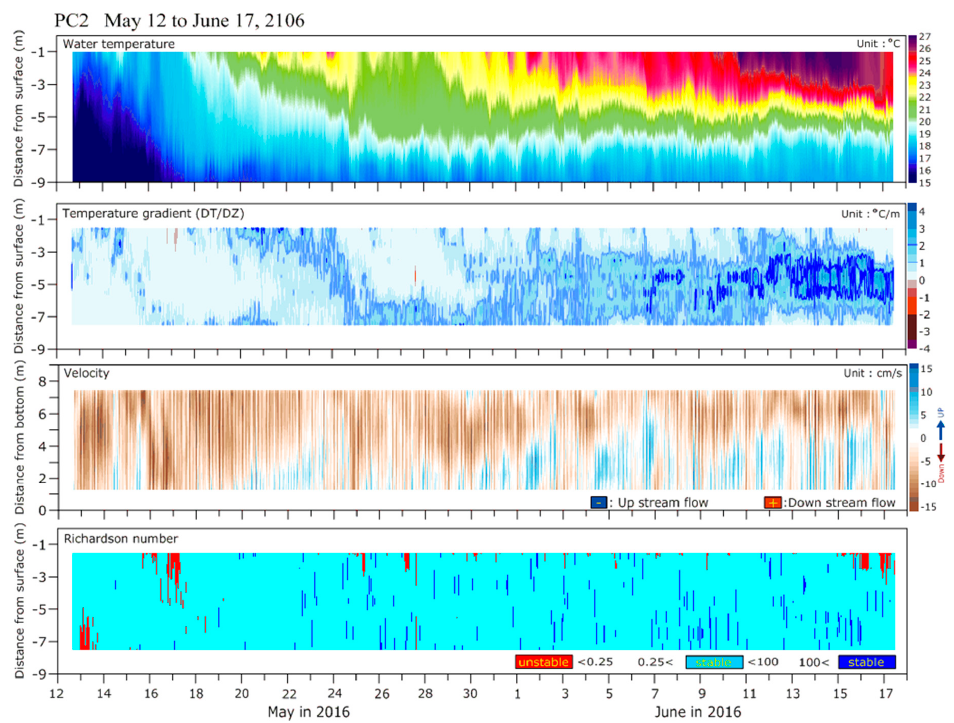
Figure 7. Profiles and time series of the water temperature, flow velocity, and Richardson number at PC2.